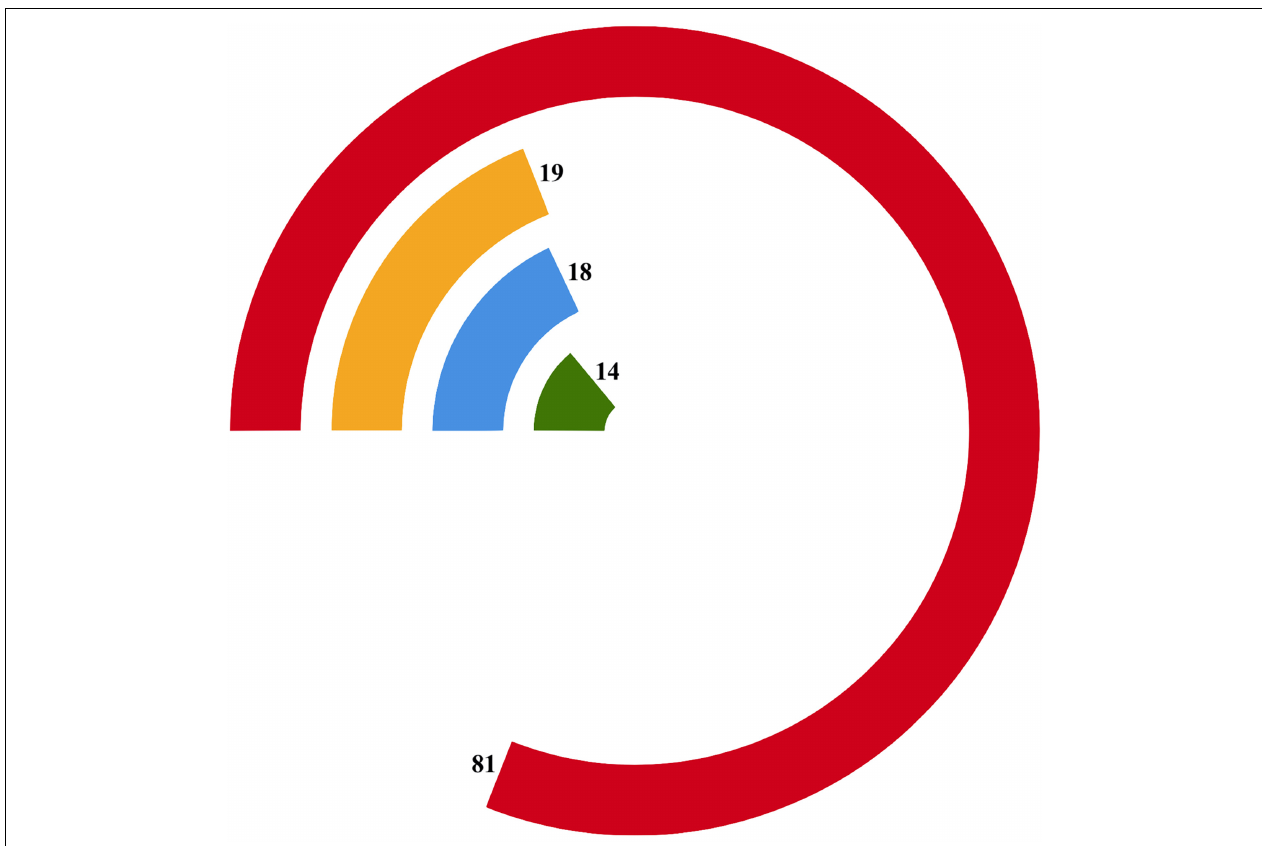
FIGURE 3 | Sub themes generated from discourse analysis of The Chronicle of Higher Education for conceptions of technology and pedagogy theme. Numbers in this figure indicate quantity of articles associated with each sub theme.